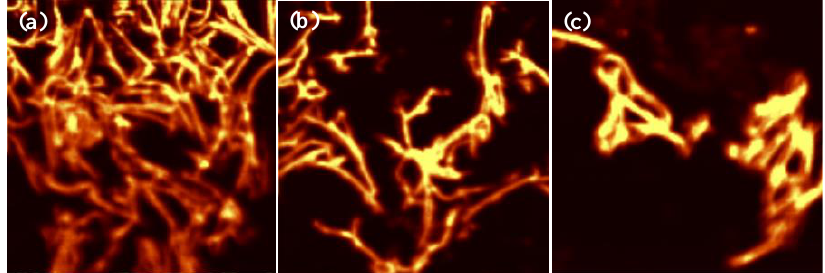
Figure 4. Laser confocal microscopy (LCM) PL mapping images of ( a ) P3MT/pDNA-tDNA (10 – 10 pairs), ( b ) P3MT/pDNA-tDNA (20 – 20 pairs) and ( c ) P3MT/pDNA-tDNA (30 – 30 pairs) NWs, upon excitation with 488-nm laser.